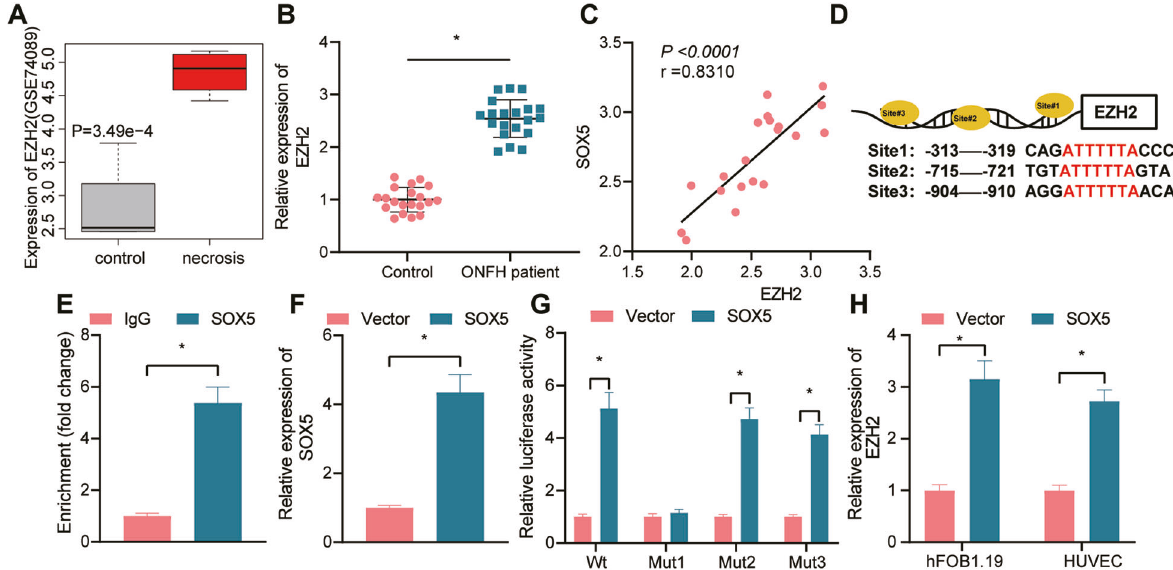
Fig. 2 SOX5 upregulates the expression of EZH2. A The expression of EZH2 predicted in the GSE74089 dataset. Red box represents ONFH samples, and gray box represents normal samples, p < 0.05; B EZH2 mRNA expression in the cartilage tissues of patients with ONFH ( n = 20) and patients with femoral neck fracture (normal control, n = 20) determined with RT-qPCR; C Pearson ’ s correlation coef fi cient of the correlation between the mRNA expression of SOX5 and EZH2 in ONFH samples; D the binding site between SOX5 and EZH2 promoter region as predicted with JASPAR CORE database; E ChIP assay of SOX5 enrichment in the EZH2 promoter region in HEK293T cells; F SOX5 mRNA expression in the HEK293T cells determined with RT-qPCR; G Targeting relationship between SOX5 and EZH2 validated with the dual- luciferase reporter gene assay; H EZH2 mRNA expression in hFOB1.19 cells and HUVECs assessed with RT-qPCR. Cell experiment was repeated three times independently. * p <